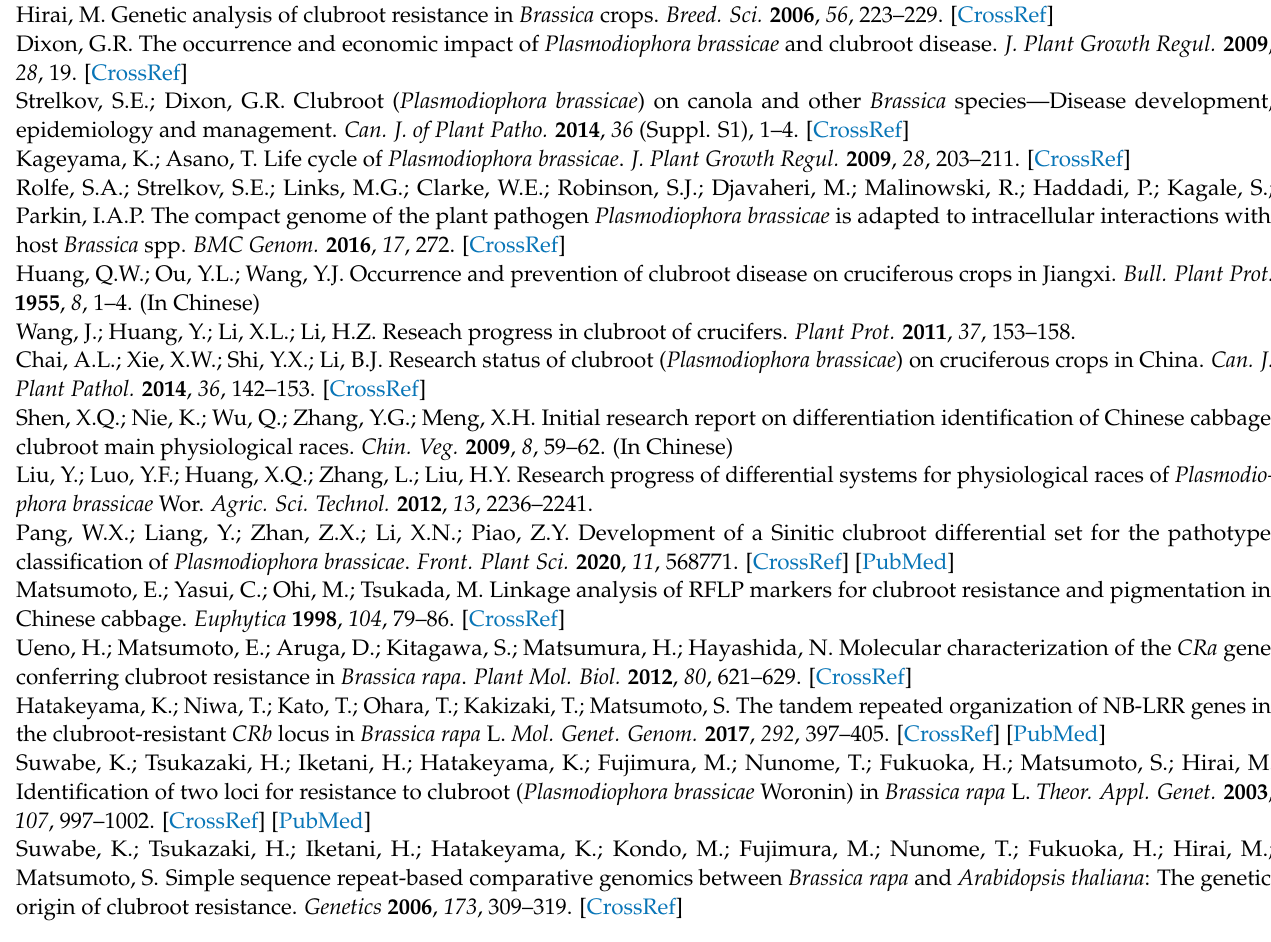
and the XYB36-2 reference genome. Figure S1: Collinearity between the clubroot resistance genes